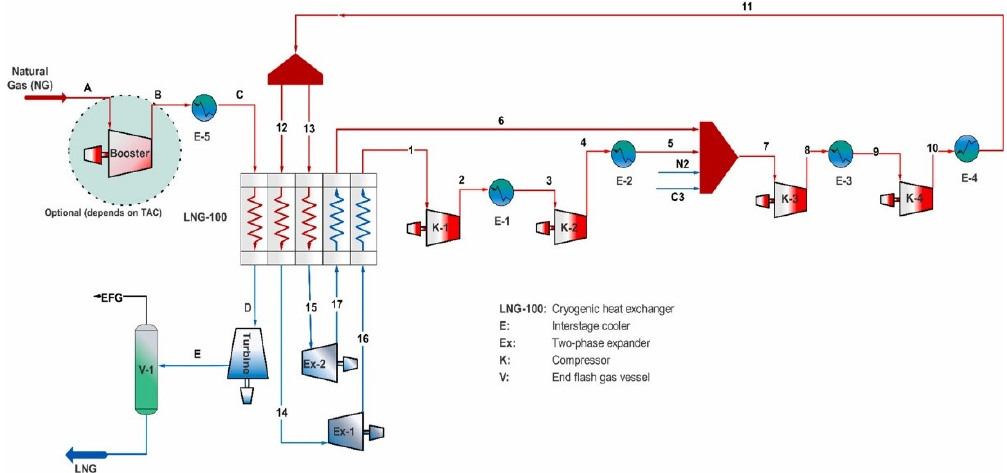
Figure 27. The variation of C p and C p /C v in different mole fractions of methane in the mixed refrigerant at standard conditions [93]. Reproduced with permission from Elsevier (license number